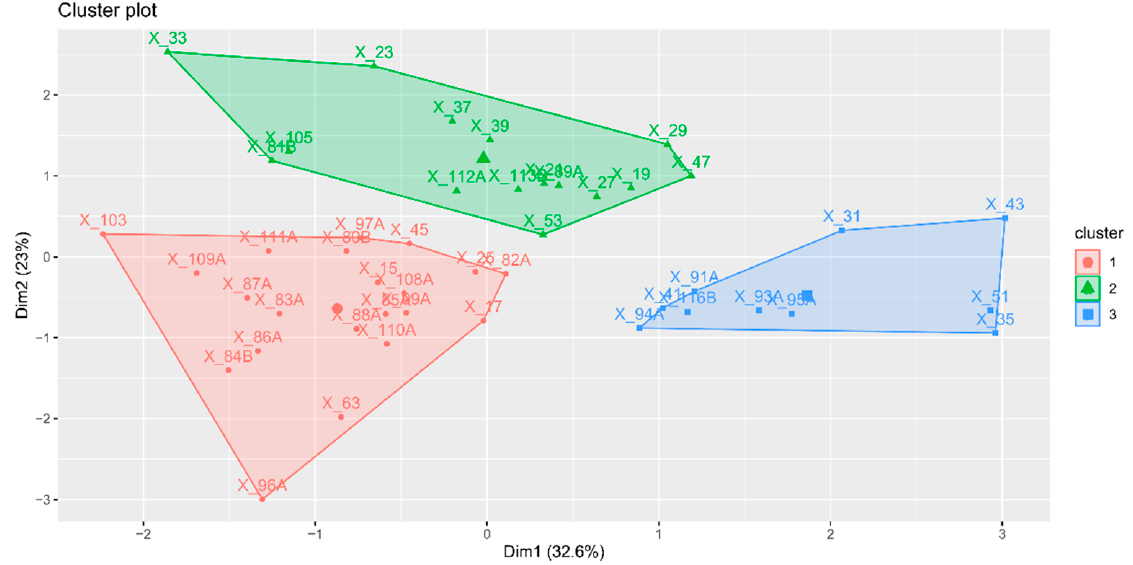
Figure 1. Hierarchical classification on principal components (HCPC) based on the gene expression of Mal d 1.01 , Mal d 1.06A , Mal d 2.01 , Mal d 3.01 , and Mal d 4.01 , in the flesh. Sample names are listed in Table 5.